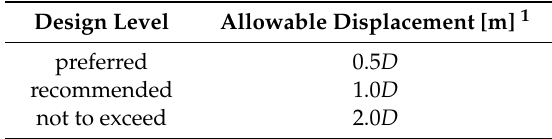
Table 2. User tolerance limits for the di ff erent design levels